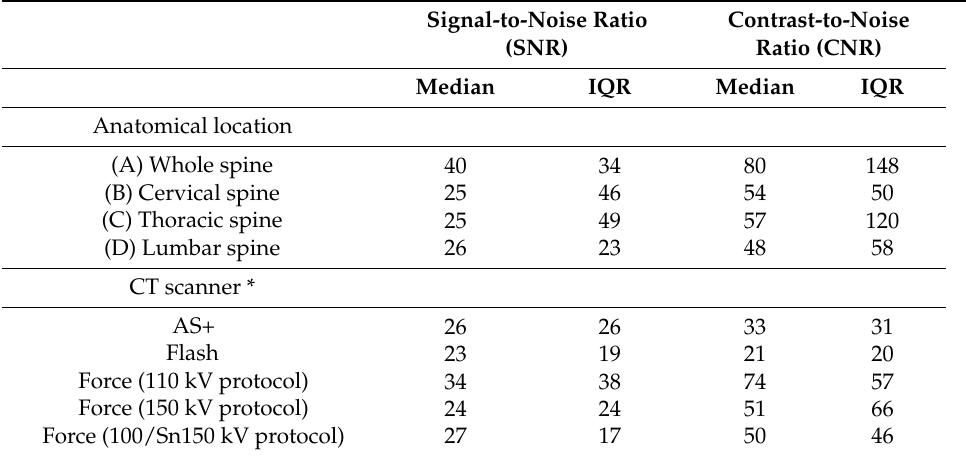
Table 4. Quantitative image quality analysis of CT